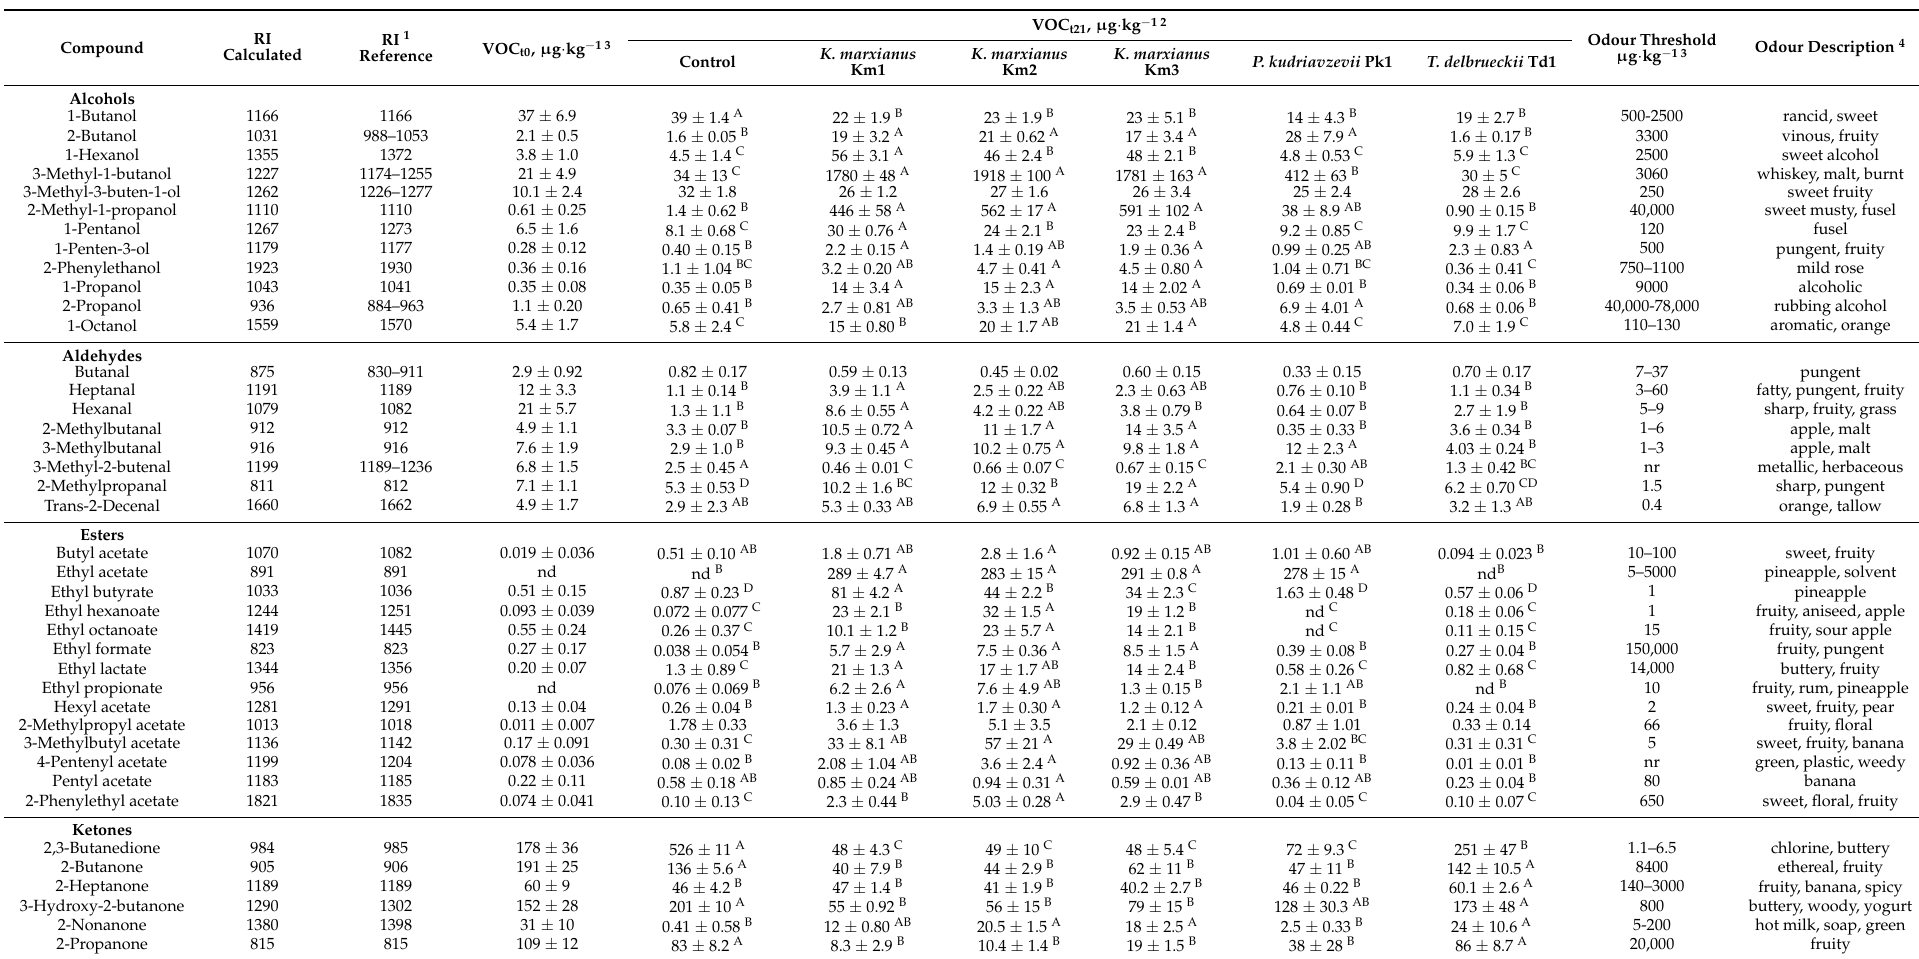
Table 2. Concentration of volatile compounds in skyr at start (VOC t0 ) and after 21 days (VOC t21 ) incubation of yeasts Kluyveromyces marxianus Km1 Km2 and Km3, Pichia kudriavzevii Pk1 and Torulaspora delbrueckii Td1, and in skyr controls (without added yeasts), VOC retention indices (RI) and threshold